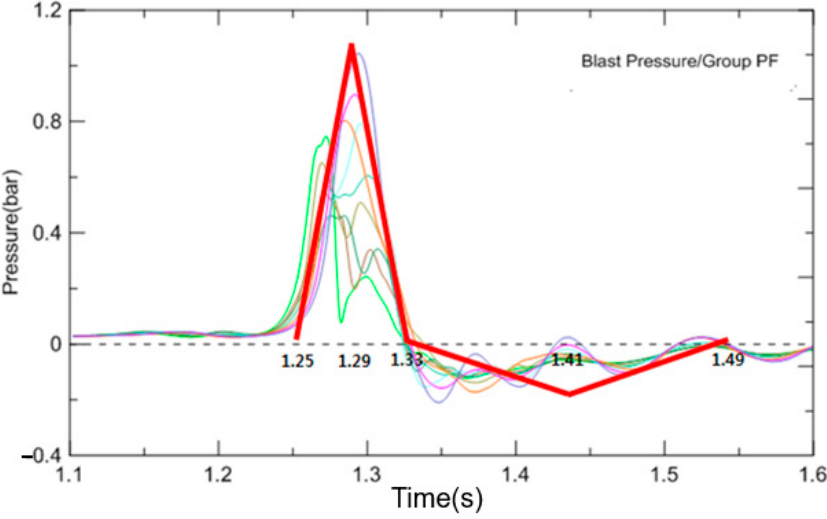
Figure 12. Idealization of blast pressure in PF (Port Forward) for application.